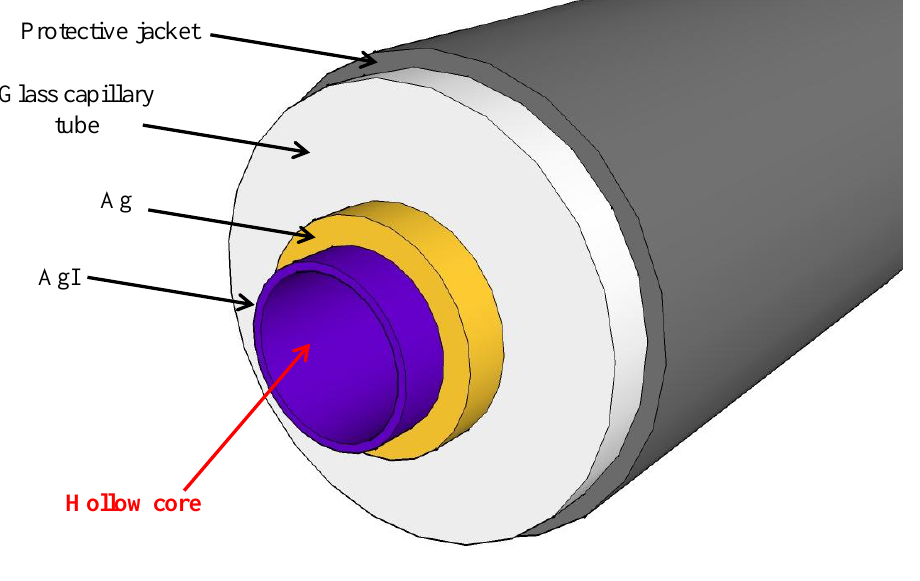
Figure 10. Simple schematic of the hollow fiber with Ag/AgI coating. Thicknesses are not drawn to